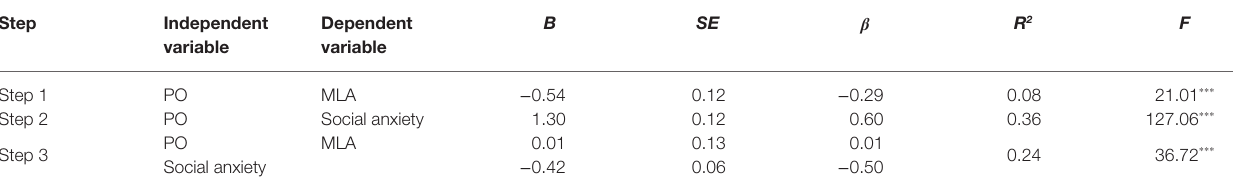
TABLE 2 | Mediating effect of social anxiety.